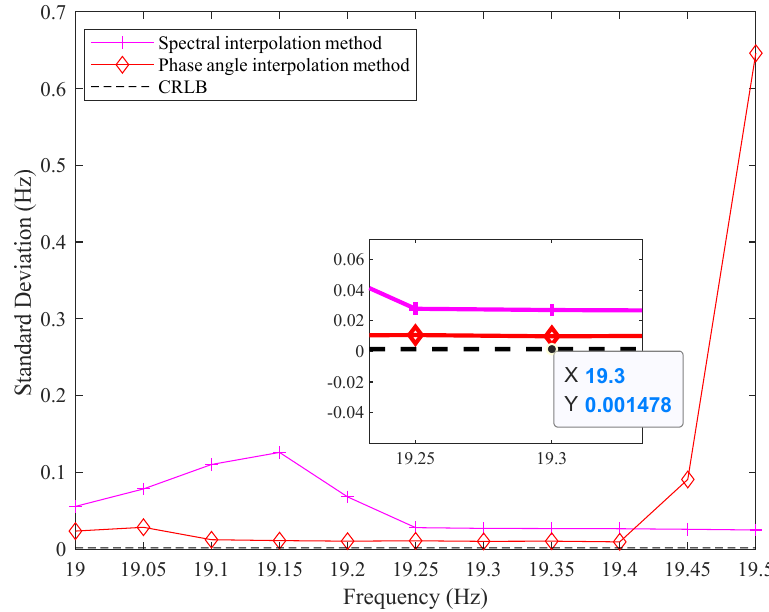
Figure 1. Correction performance of the phase angle interpolation method (SNR is − 6 dB).